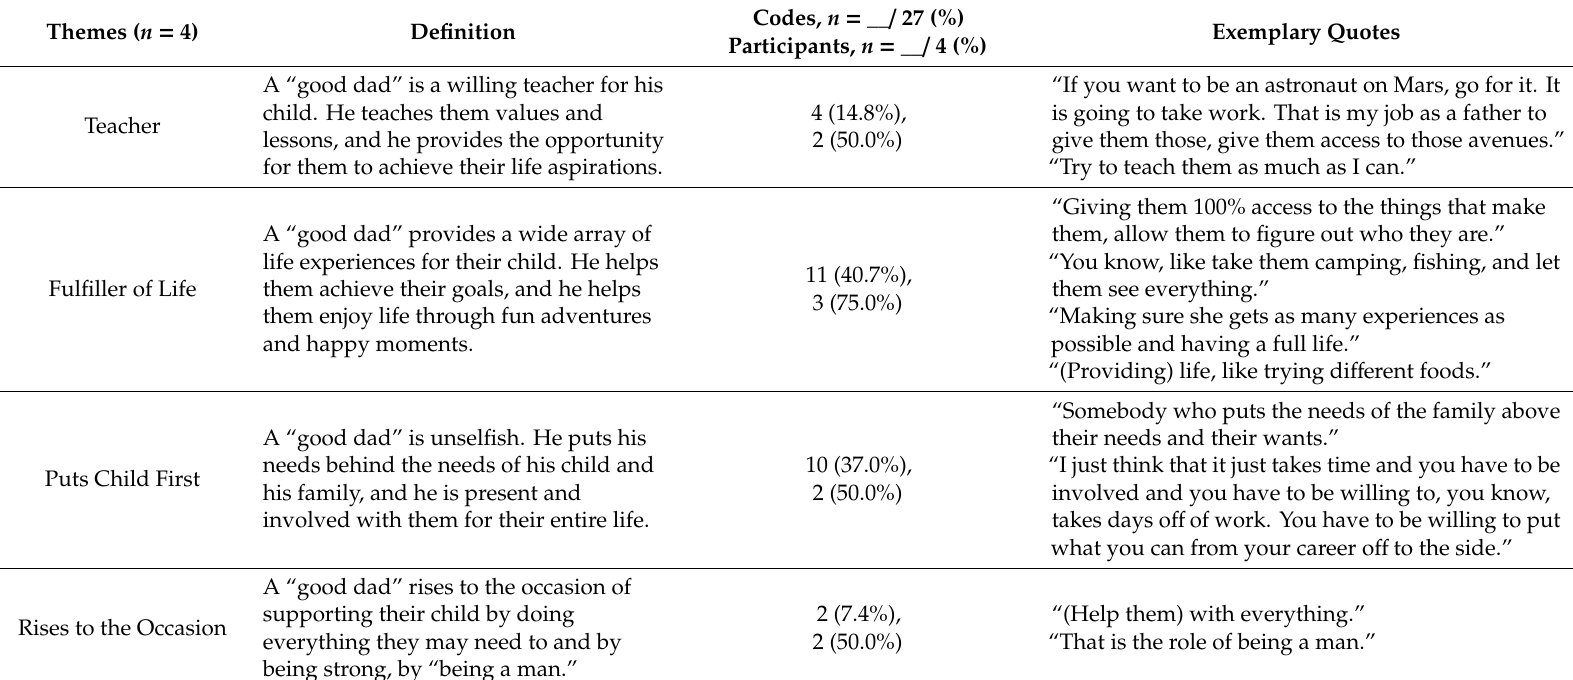
Table 2. Paternal definition of “being a good dad to my